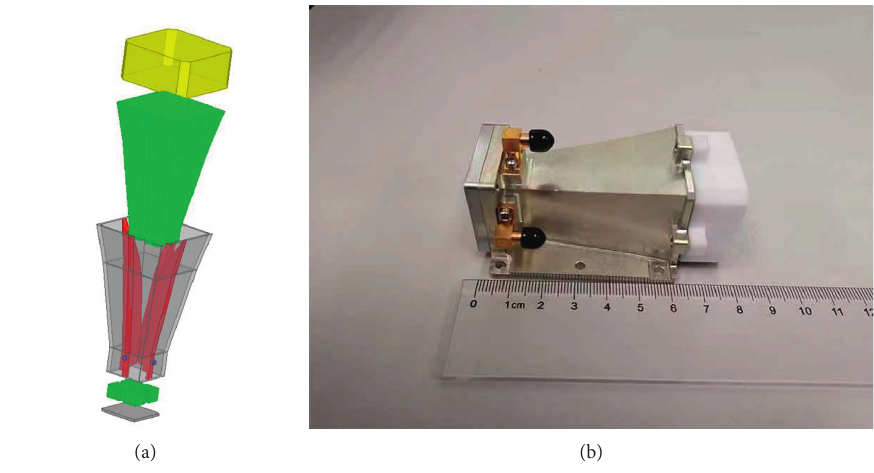
Figure 1: (a) The structure and (b) the photograph of the lens-loaded